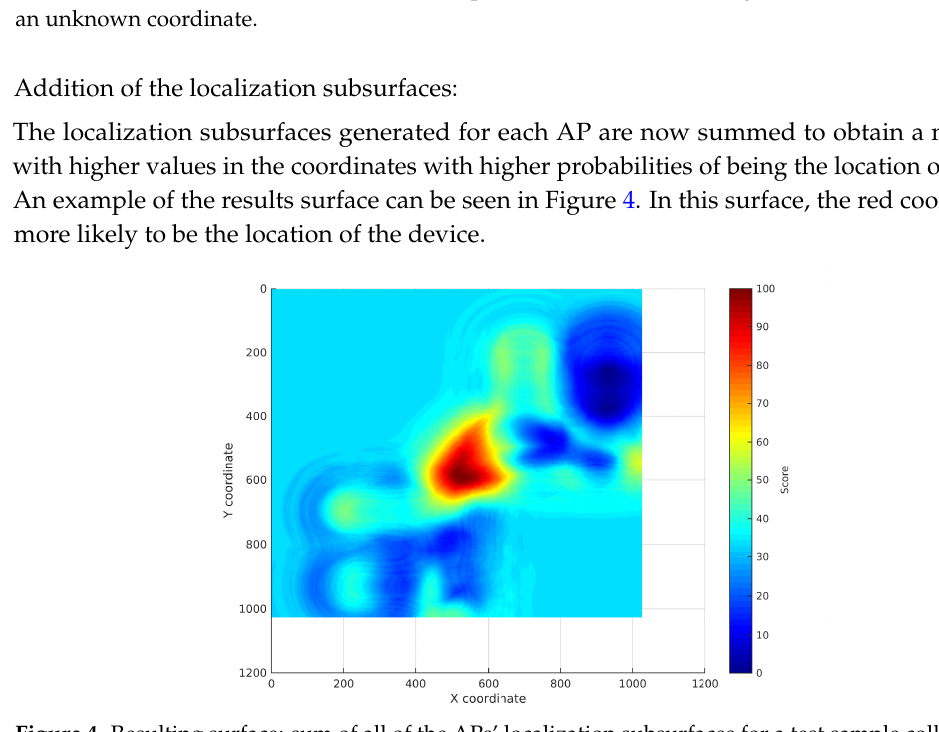
Figure 4. Resulting surface: sum of all of the APs’ localization subsurfaces for a test sample collected at an unknown